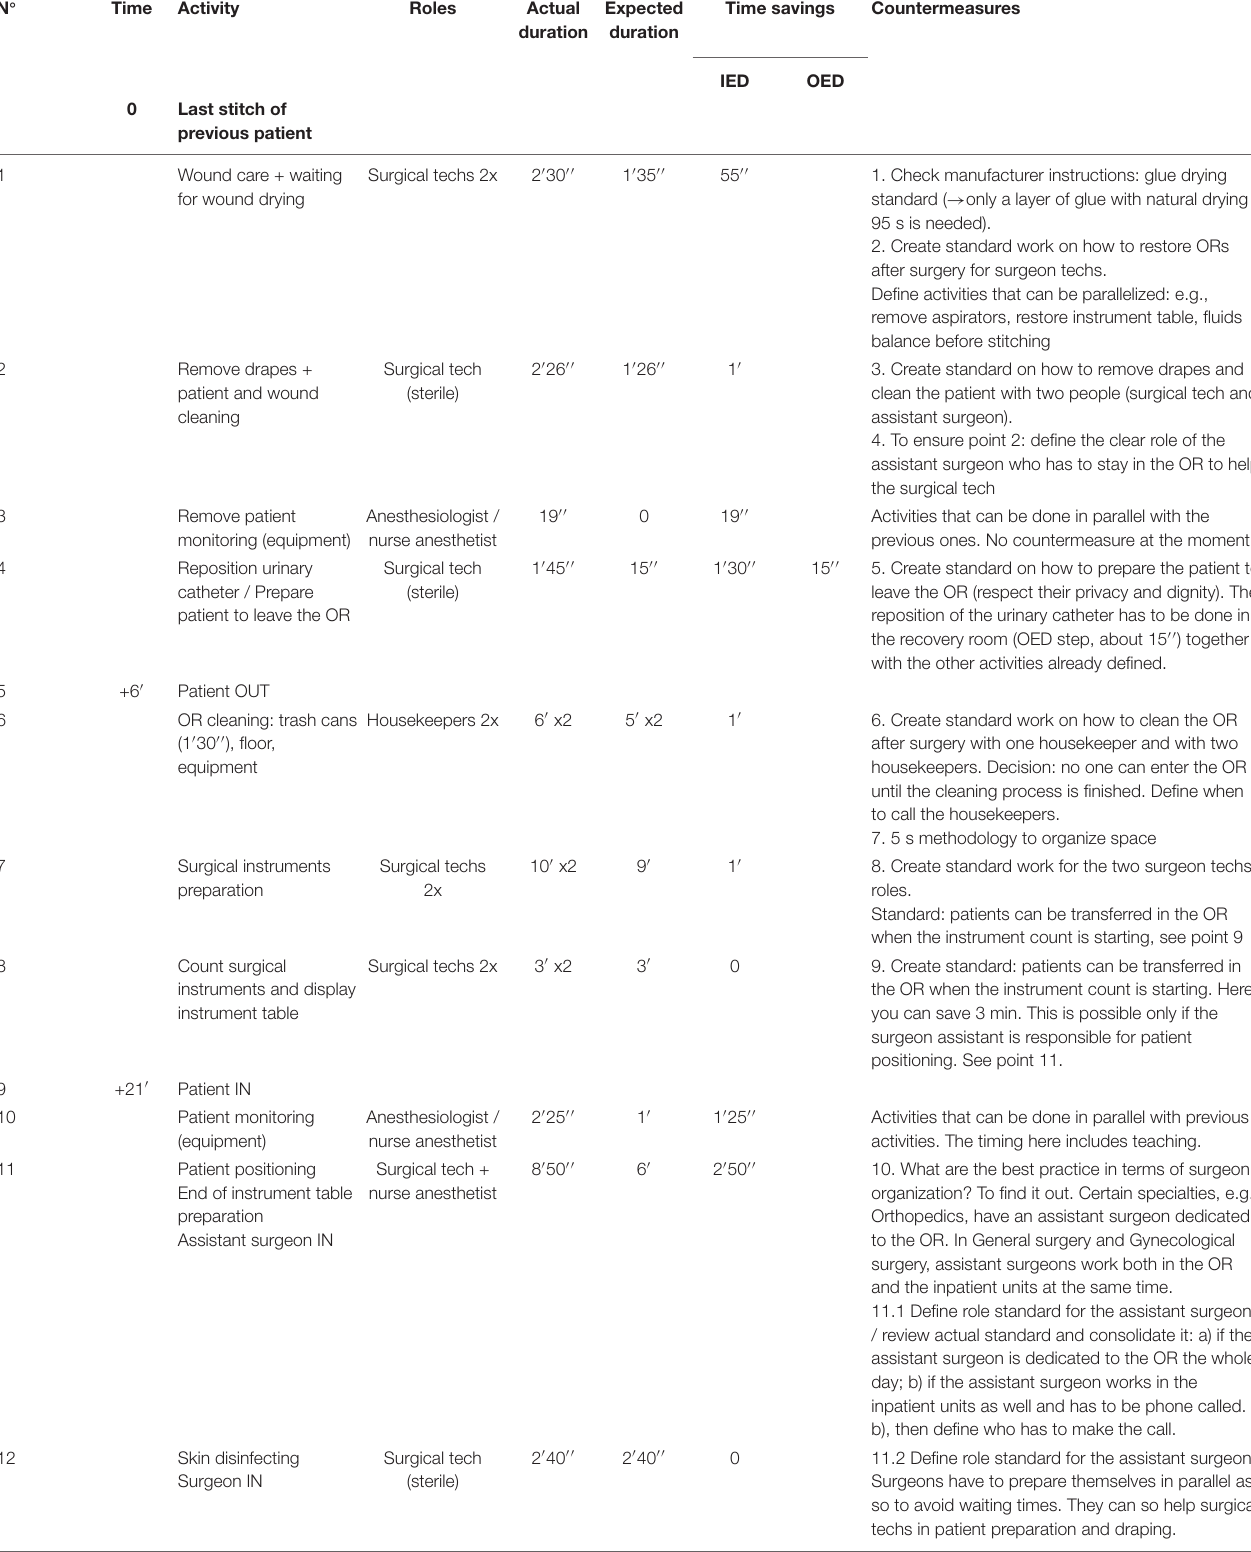
TABLE 2 | Single-minute exchange of die (SMED) analysis and countermeasures. N